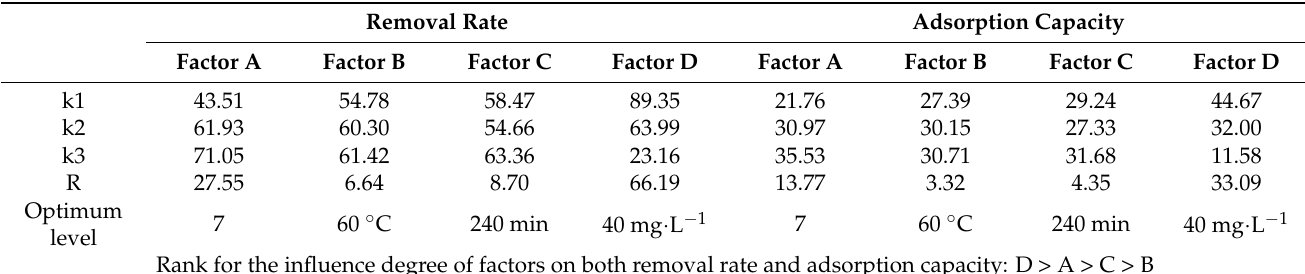
Table 8. Range analysis of removal rate and adsorption